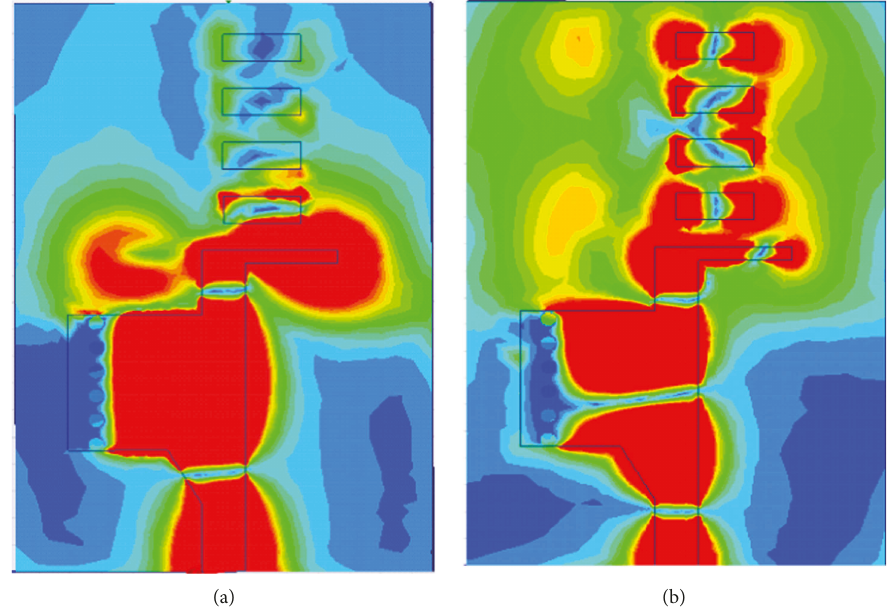
Figure 9: Simulated surface current distribution of proposed Yagi antenna at di ff erent frequencies: (a) 12 GHz; (b) 18 GHz.